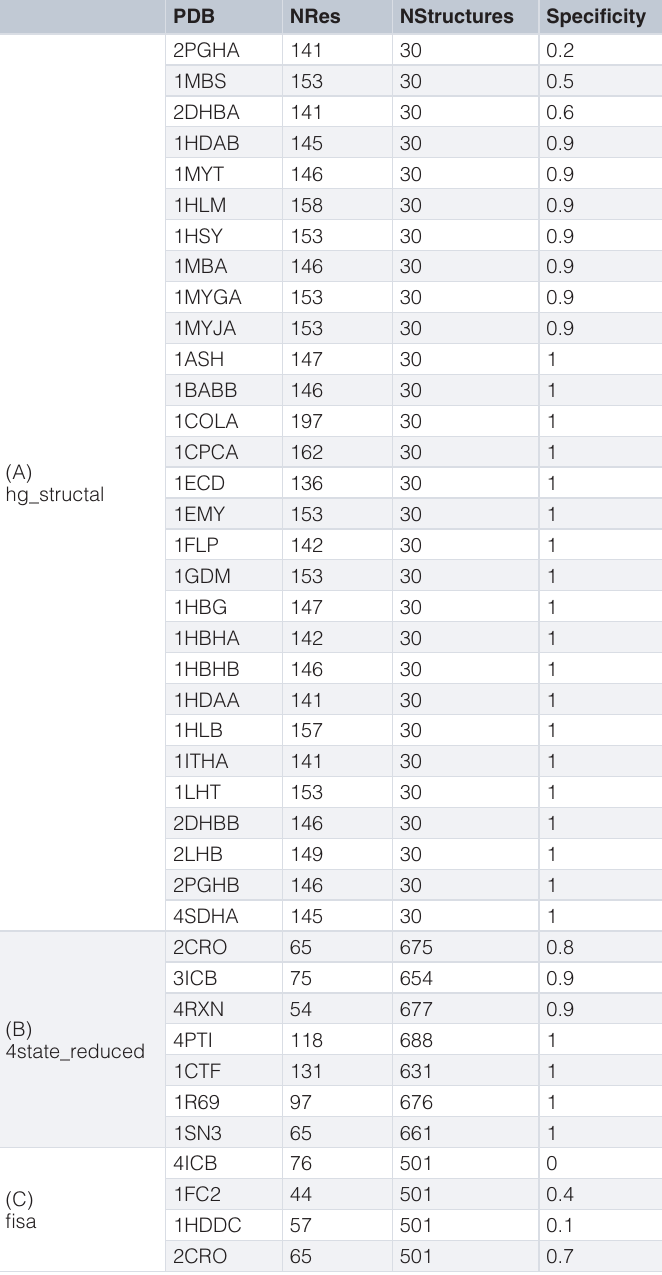
Table 5. hg_structal and 4state_reduced decoy sets. The PDBs are sorted based on specificity. (A) The hg_structal decoy set has ∼ 30 protein structures - each of which has 30 structures. The average specificity obtained for the set is 0.91. (B) The 4state_reduced decoy set has 7 protein structures - each of which has ~ 600 structures. The average specificity obtained for the set is 0.94. (C) The fisa set has 4 protein structures - each of which has 500 structures. The electrostatic discriminator has low specificities in this case. We have previously demonstrated that this decoy set can be discriminated by a distance based criterion. It consists of physically nonviable structures, thus rendering an electrostatic analysis meaningless. NRes = number of residues, NStructures = number of structures in the decoy set. PDB